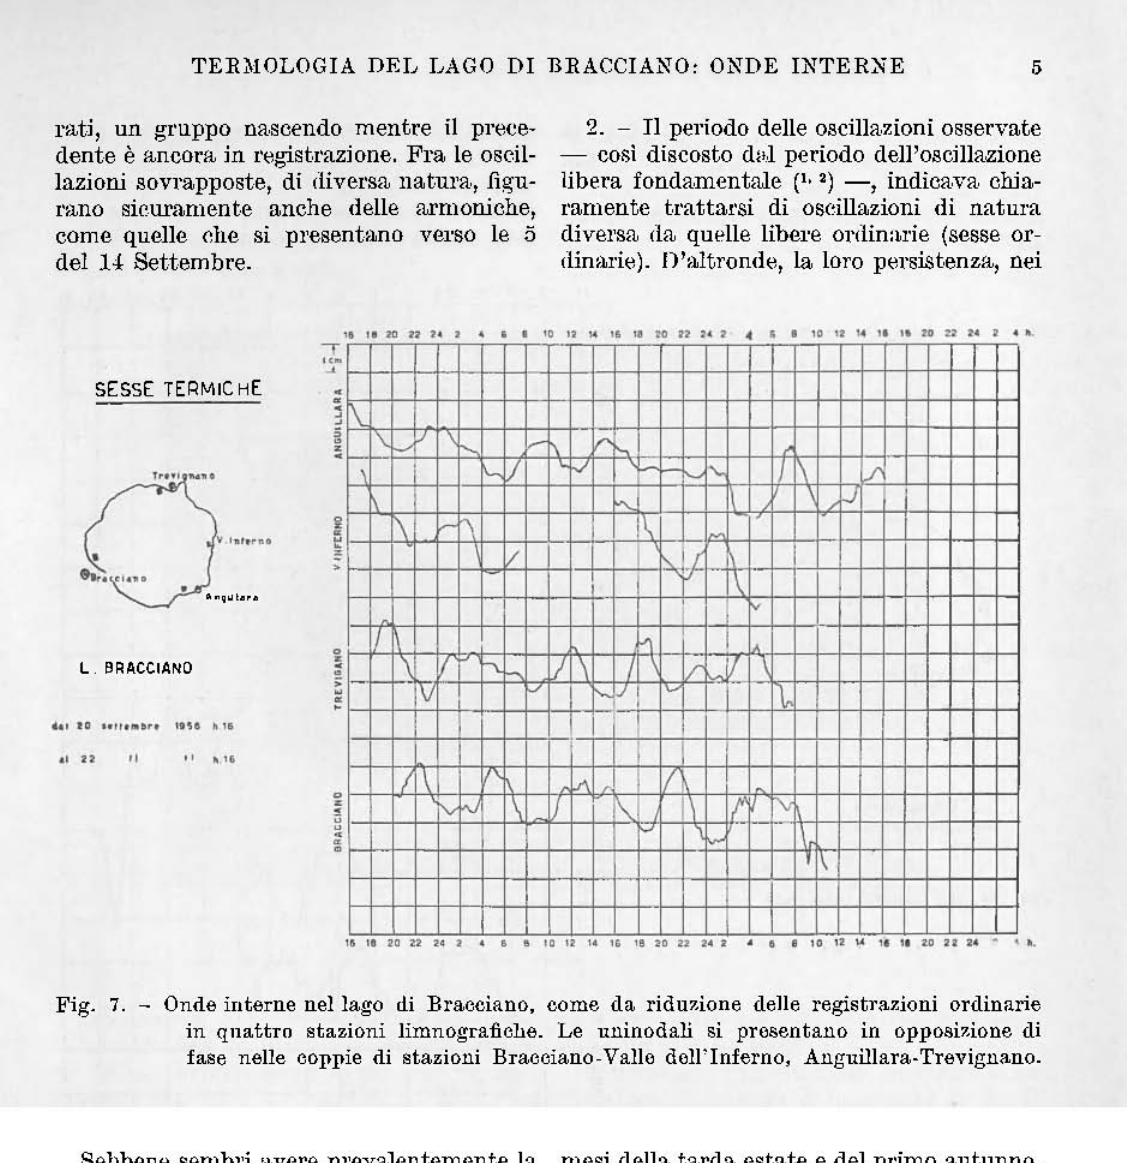
Fig. 7. - Onde interne nel lago di Bracciano, come da riduzione delle registrazioni ordinarie in quattro stazioni limnografìche. Le uninodali si presentano in opposizione di fase nelle coppie di stazioni Bracciano·Valic dell'Inferno, Anguillara-Trevignano_